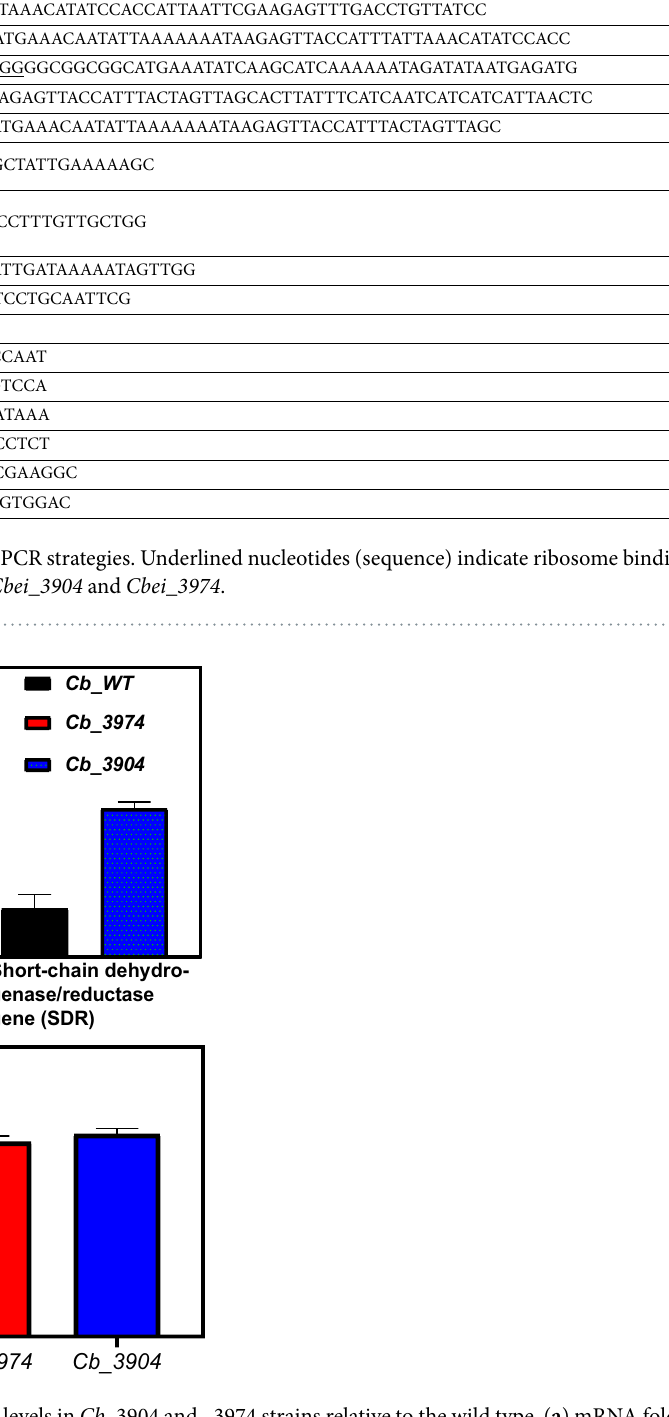
Figure 1. Fold changes in mRNA levels in Cb _3904 and _3974 strains relative to the wild type. ( a ) mRNA fold changes of Cbei_3974 (AKR) and Cbei_3904 (SDR) in Cb _3904 and _3974 relative to Cb _wild type. ( b ) mRNA fold changes of 16S rRNA gene in Cb _wild type, Cb _3904 and